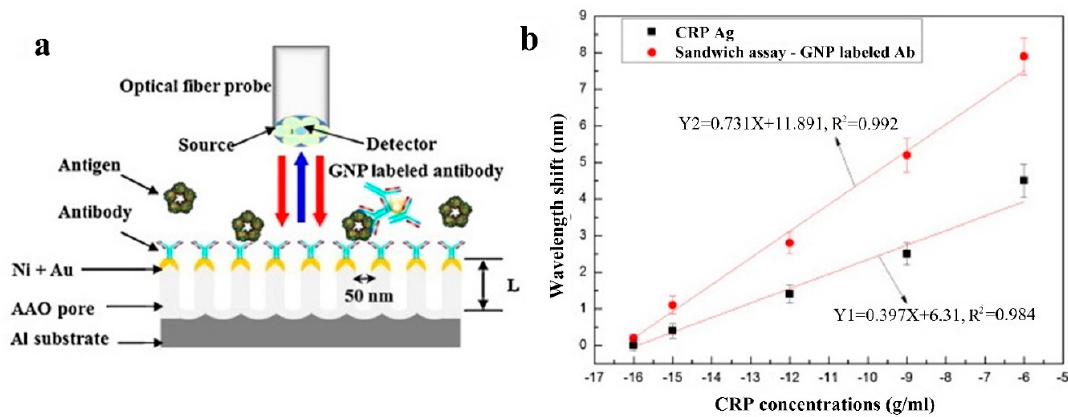
Figure 13. ( a ) Schematic cross-sectional figure showing the structure of a fabricated anodicaluminum oxide (AAO) chip for CRP detection. ( b ) The linear regression of the resonance wavelength shift after CRP antigen–antibody reaction (black squares) and after gold nanoparticle labelled CRP secondary antibody reaction (red circles). ( a , b ) Reprinted [141], Copyright 2013, with permission from Elsevier.